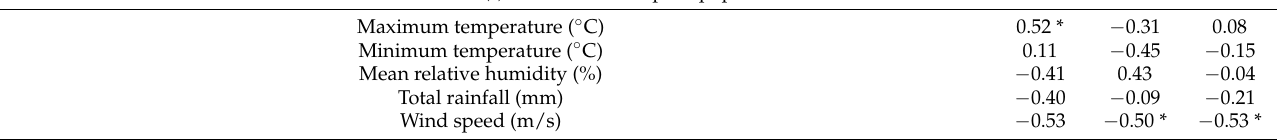
Mean no. of Pea Aphid per 20 Twigs in the